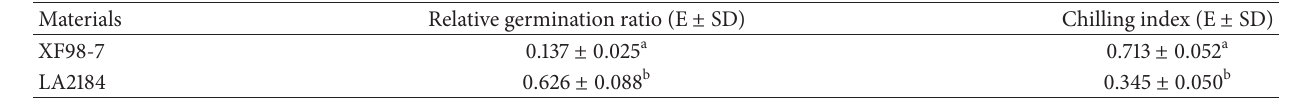
Table 1: Phenotype analysis of parental lines.